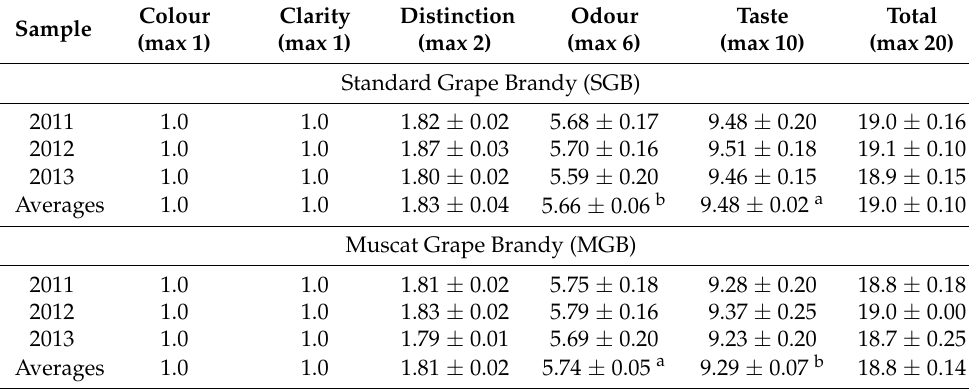
Table 6. Sensory analyses of grape brandies (average values ±